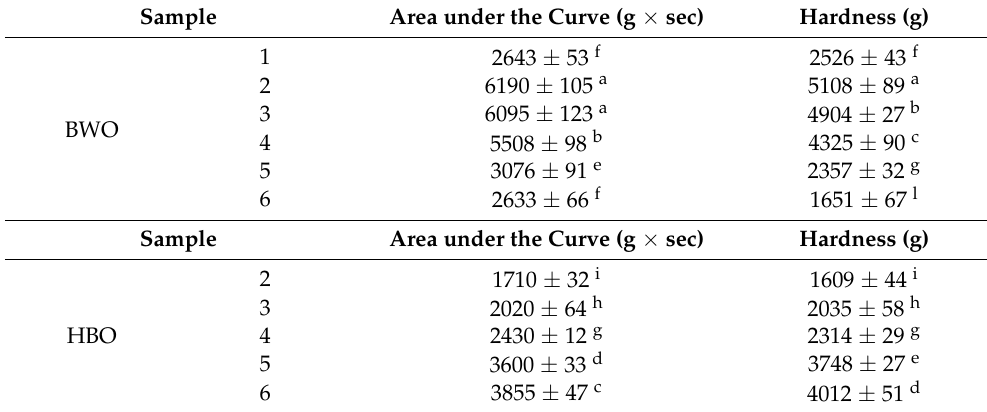
Table 5. Spreadability test parameters of margarine samples formulated with BWO and HBO.